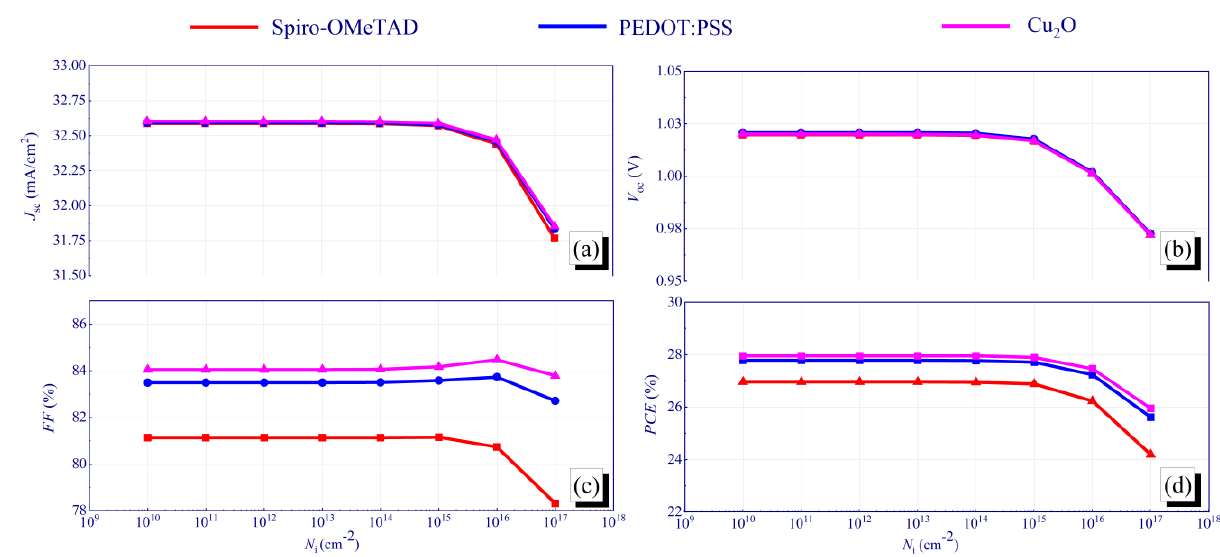
Figure 4. Influence of the concentration of interfacial defects ( N i ) at the TiO 2 /CH 3 NH 3 SnI 3 (IL1) and С H 3 NH 3 SnI 3 /HTL (IL2) interfaces: ( a ) J SC , ( b ) V OC , ( c ) FF , ( d ) PCE .